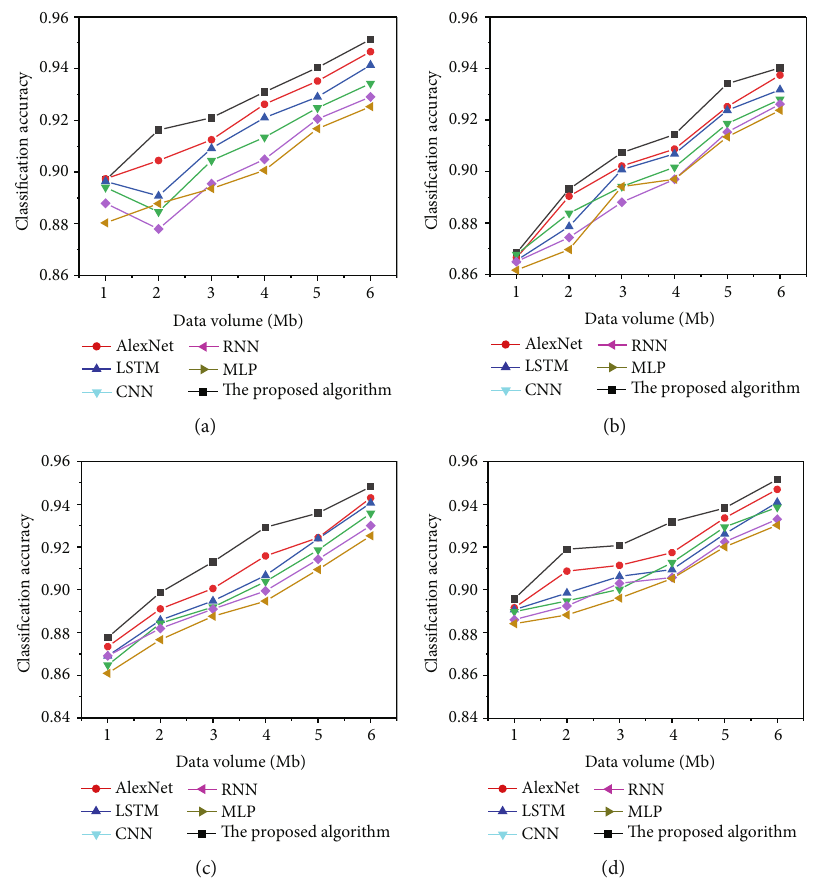
Figure 8: Classi fi cation accuracy change with the increase of the amount of data under di ff erent algorithms in each node ((a) node A; (b) node B; (c) node C; (d) node